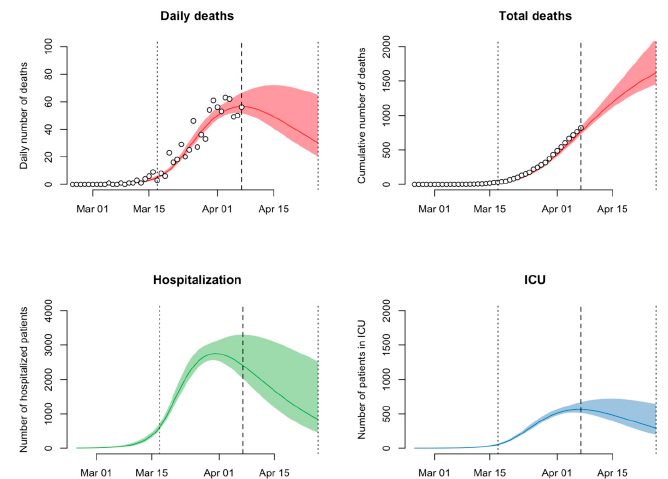
Figure 4. Projected numbers of daily deaths, total deaths, hospitalizations, and patients in ICU for the COVID-19 epidemic in Switzerland shown on a linear scale (top panels) and a logarithmic scale (bottom panels). Vertical dotted and dashed lines indicate the time points of the social distancing measure (17 March 2020) and the last data point (7 April 2020). Source: Althaus, Christian, “Real-time modeling and projections of the COVID-19 epidemic in Switzerland”.